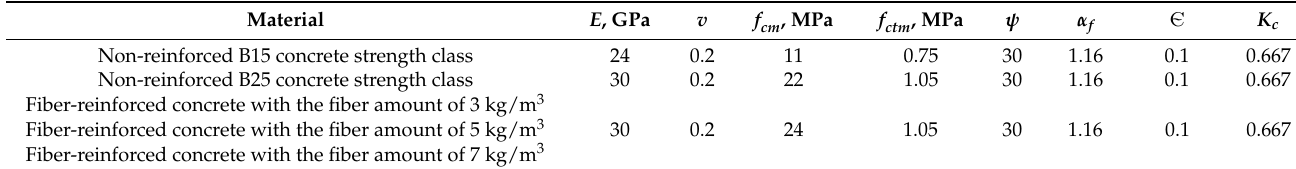
Table 2. Parameters of the model of plastic behavior of concrete with damage accumulation. Material